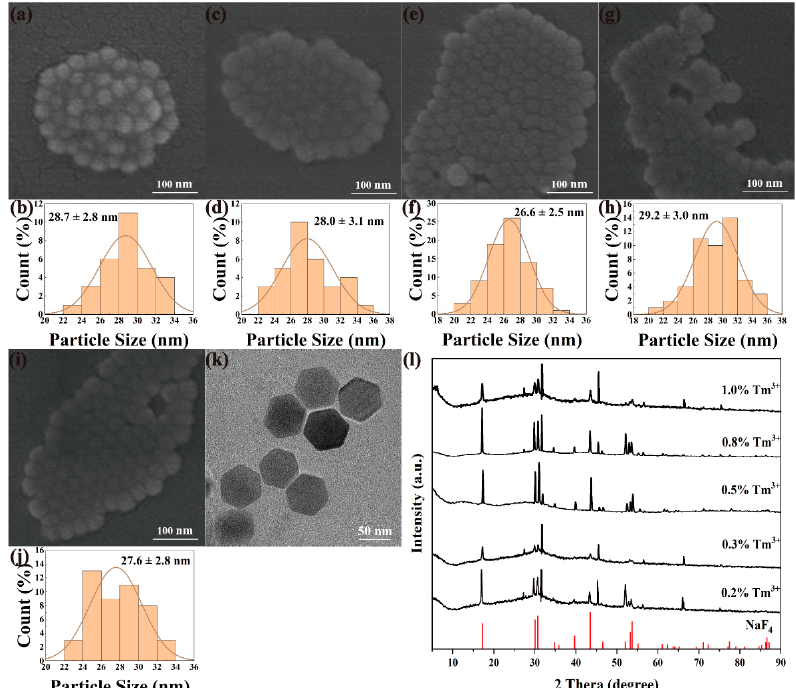
Figure 5. SEM, particle size analysis, TEM, and XRD images of NaYF 4 : 20%Yb 3+ , x%Tm 3+ . ( a ) x = 0.2, ( c ) x = 0.3, ( e ) x = 0.5, ( g ) x = 0.8, ( i ) x = 1.0; particle size analysis: ( b ) x = 0.2, ( d ) x = 0.3, ( f ) x = 0.5, ( h ) x = 0.8, ( j ) x = 1.0; ( k ) TEM image of NaYF 4 : 20%Yb 3+ , 0.5%Tm 3+ ; ( l ) NaYF 4 : 20%Yb 3+ , x%Tm 3+ (X = 0.2, 0.3, 0.5, 0.8, 1.0).